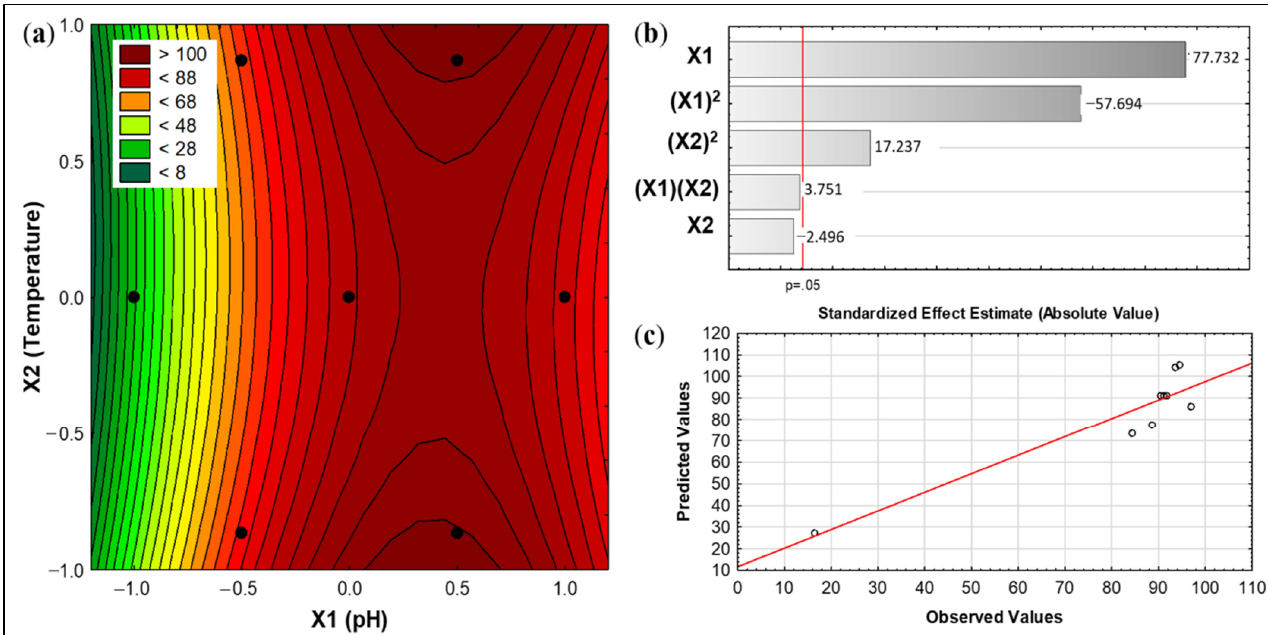
Figure 9. Response surface for the percent adsorption removal of MB by SAP after 24 h of continuous recirculation. ( a ) Contour plot of adsorption as a function of pH and temperature; ( b ) Pareto chart of standardized effect estimates; and ( c ) residual plot showing observed vs. predicted values. ( C MB,0 = 50 ppm; V = 300 mL; m SAP,0 = 70 mg.).